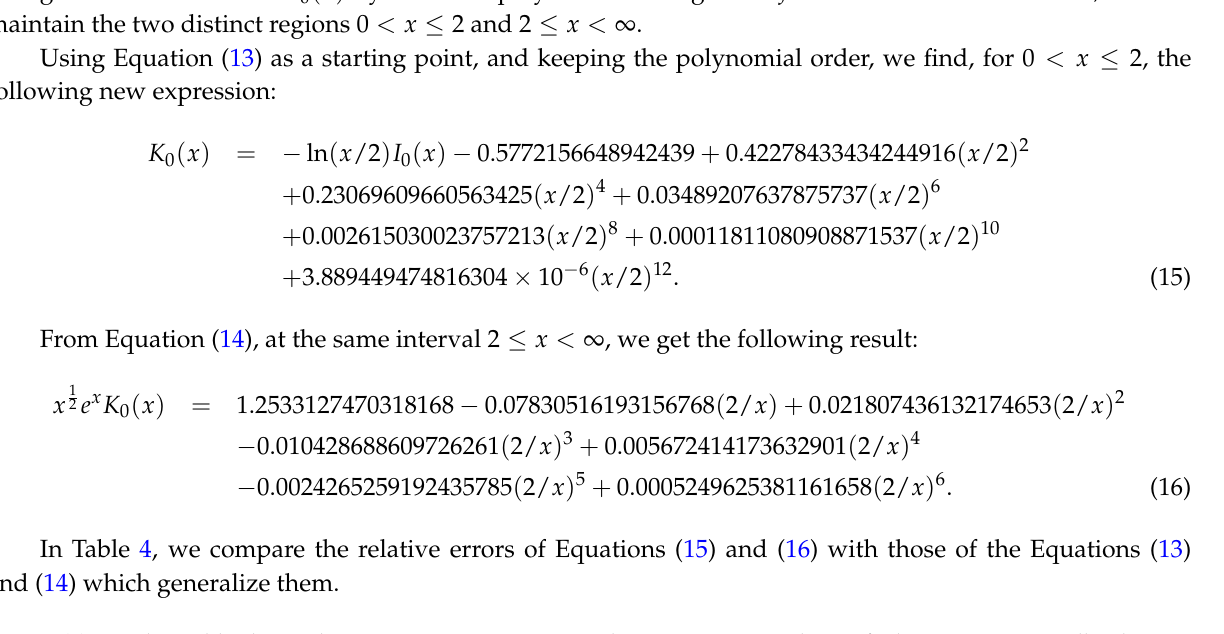
Equations (13) and (14), and comparing them, respectively, to the analogous new polynomial approximation we propose, given by Equations (15) and